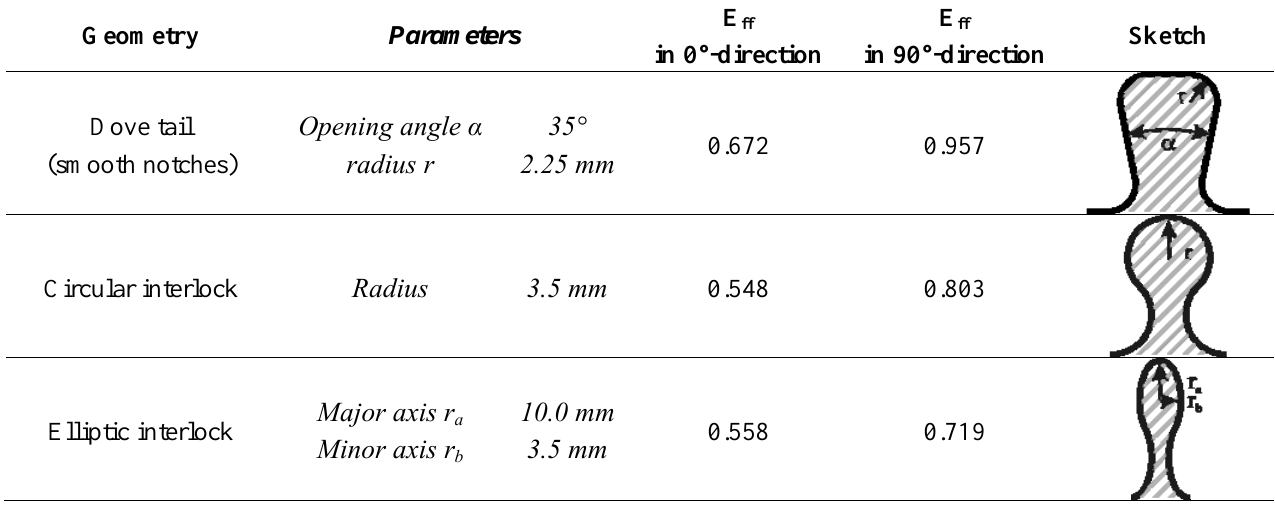
Table 6. Resultant stress efforts of the analyzed undercut